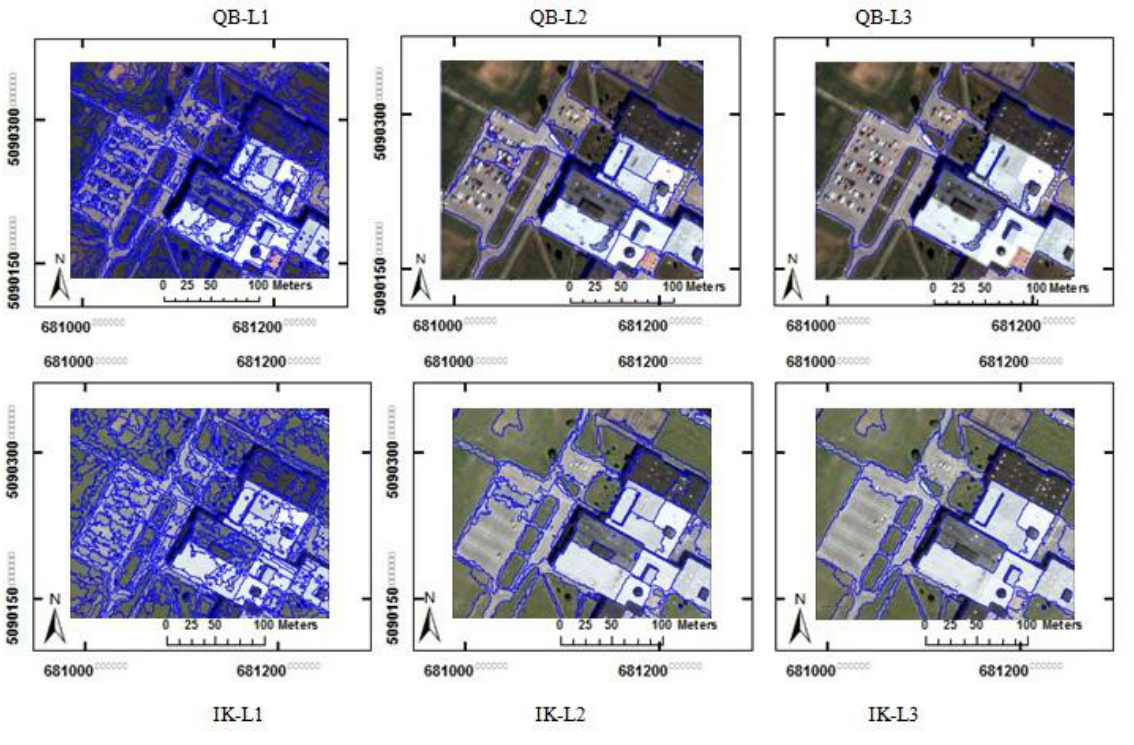
Figure 4. Multi-resolution segmentation results of level 1 (L1), level 2 (L2), and level 3(L3) for a sample area of QB ( top ) and IK ( bottom ) Test